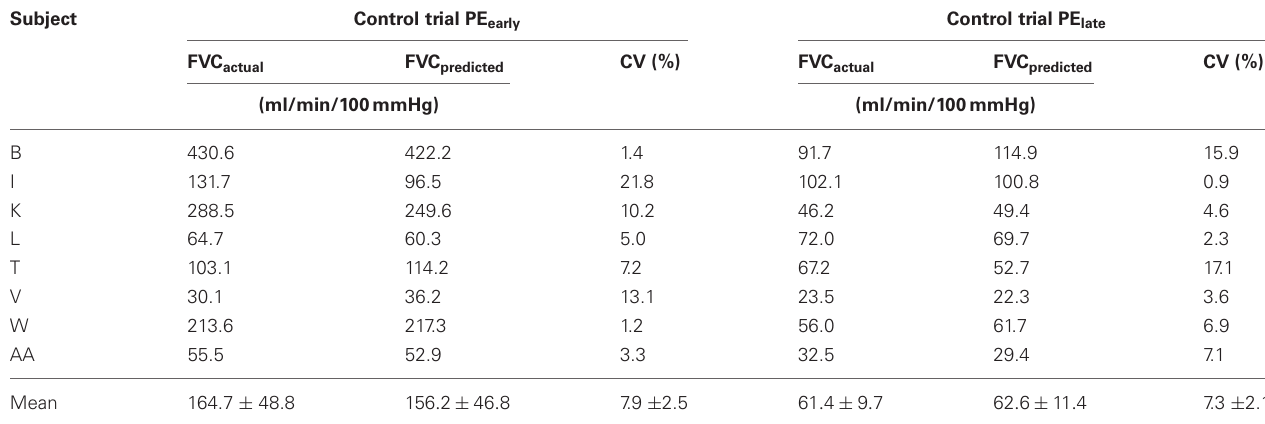
Table 2 | FVC actual and FVC predicted for control trials in PE early and PE late